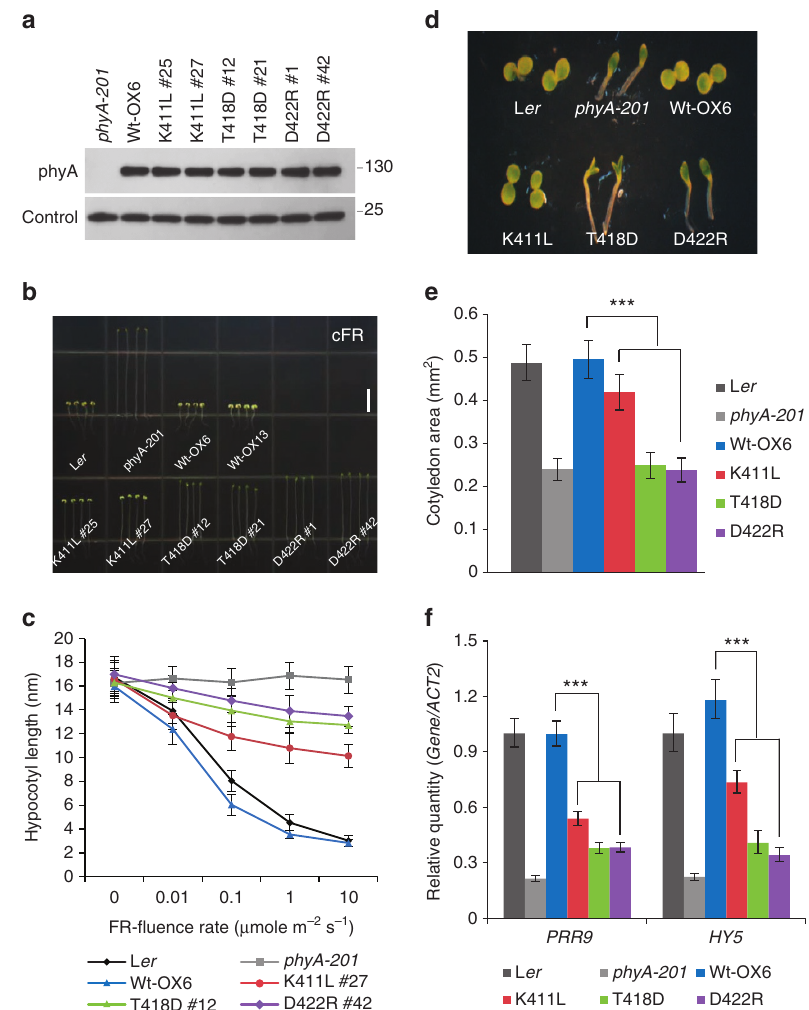
Figure 5 | Photoresponse analyses of transgenic phyA-201 plants with AsphyA kinase mutants under far-red light. ( a ) Western blot analysis to show the protein levels of AsphyA in transgenic plants. Loading controls are shown in the lower panel. phyA-201 , phyA-deficient Arabidopsis thaliana (L er ecotype); WT-OX6, transgenic phyA-201 plant with WT AsphyA; K411L, T418D and D422R, transgenic phyA-201 plants with corresponding AsphyA kinase mutant. ( b ) Hypocotyl de-etiolation of representative seedlings grown for 5 days under cFR light condition (10 m molm (cid:3) 2 s (cid:3) 1 ). Scale bar, 5mm. ( c ) Far-red fluence-rate response curves for the inhibition of hypocotyl growth. Data are expressed as means ± s.d. ( n Z 30). ( d ) Cotyledon expansion of 4-day-grown seedlings under cFR. ( e ) Comparisons of cotyledon areas. Data are expressed as means ± s.d. ( n Z 15). Statistically significant changes compared with WT- OX6 are indicated (*** P o 0.001, as determined using Tukey’s test). ( f ) Quantitative RT-PCR analysis of PRR9 and HY5 in 3-day-old etiolated seedlings exposed to 2h far-red (10 m molm (cid:3) 2 s (cid:3) 1 ). Statistically significant changes compared with WT-OX6 are indicated (*** P o 0.001, Tukey’s test, n ¼ 3